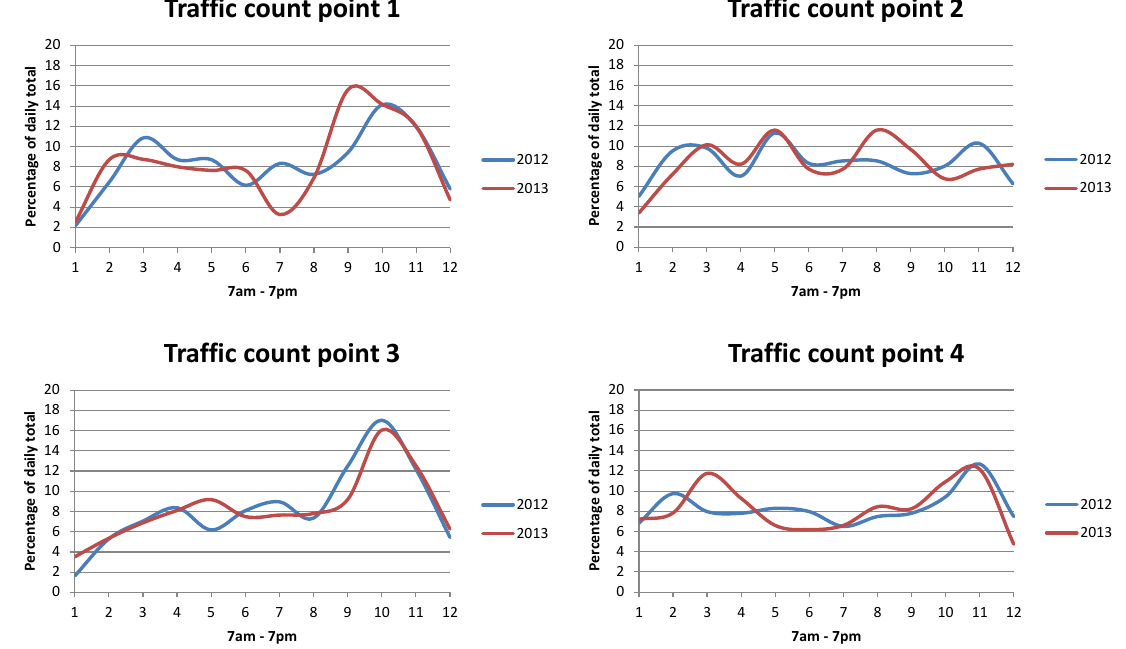
Figure 4. Hourly distribution of all traffic exiting the University of